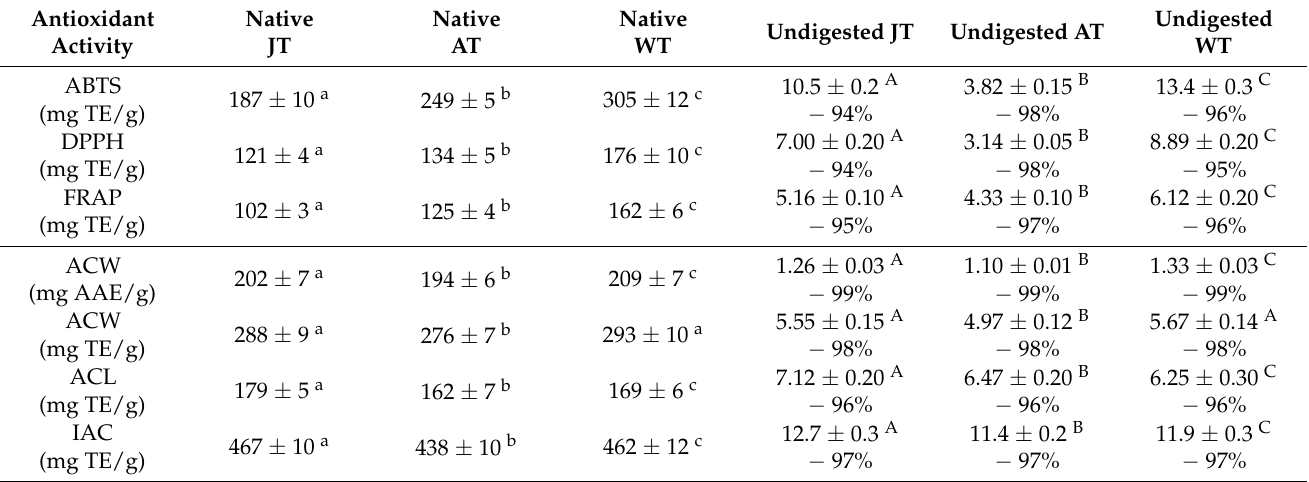
Table 4. Antioxidant activity (AOA) values determined in native and undigested part of matcha